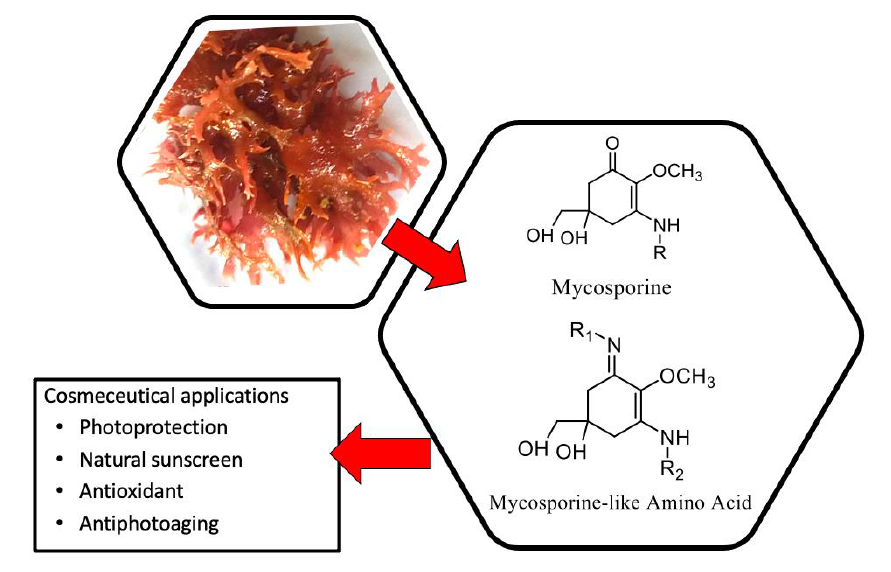
Figure 5. Mycosporines and the applications for cosmeceuticals.